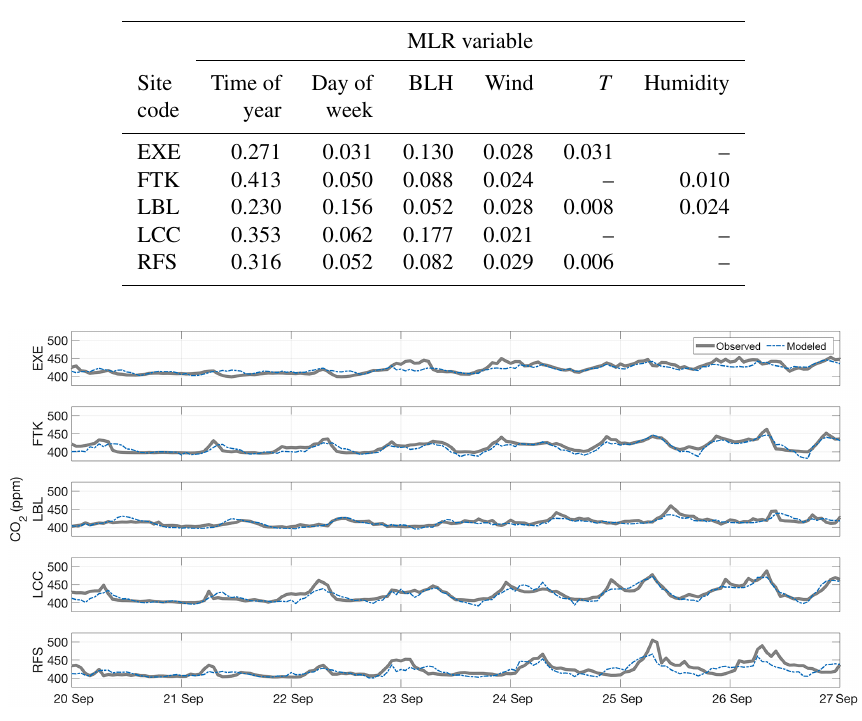
Table 2. Explanatory variables included in the multiple-linear-regression analysis of each site; values indicate the correlation coefficient increase achieved by subsequent inclusion of each variable.